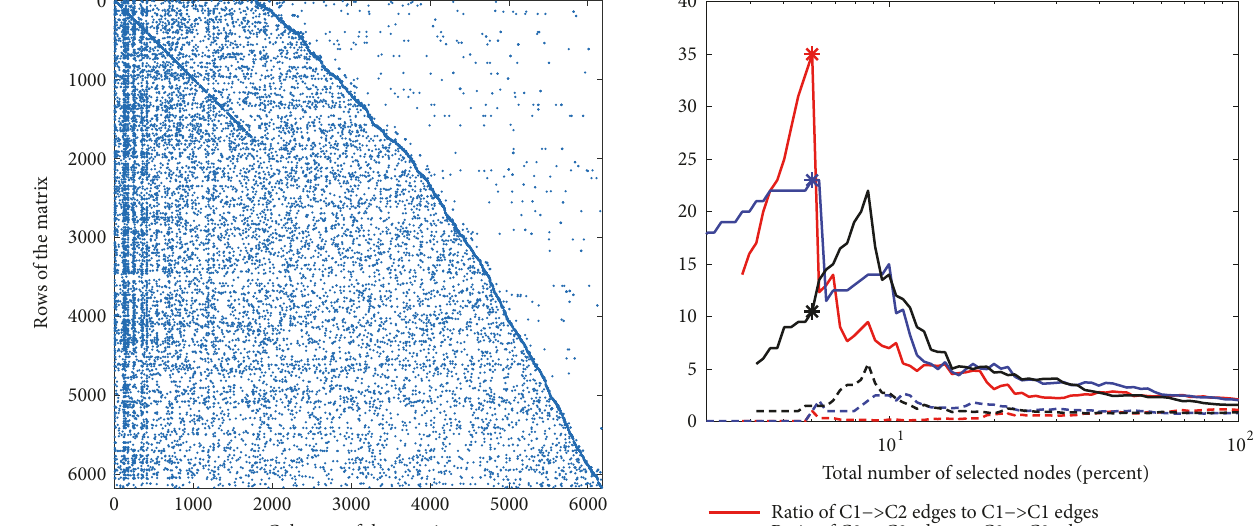
concentration of eigenvalues inside the disk of small